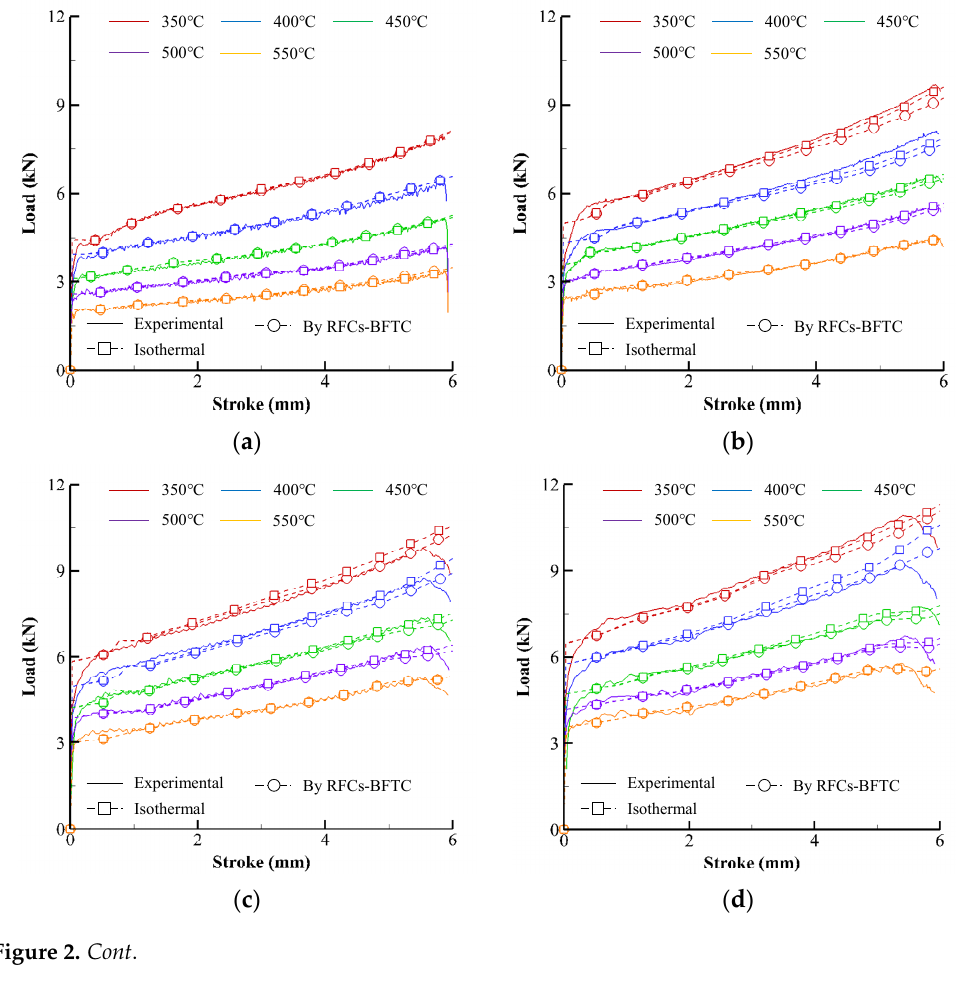
The compression test at 450 ◦ C and a strain rate of 10 s − 1 was selected for checking the validity of the calculated flow curves in the next section. Note that the measured maximum diameter of the compressed specimen was 13.7 mm at the final stroke of 6.3 mm. Solid lines in Figure 2 describe the experimental compression load–stroke curves (experimental CLSCs). The dashed lines with square or circle marks in Figure 2 repre- sent the CLSCs obtained by isothermal and non-isothermal flow analyses of the cylinder compression test, respectively, using the primitive flow curves directly calculated from Solid lines in Figure 3 exhibit the approximate primitive flow curves for the sample the experimental CLSCs (see the RFCs–BFTC in Figure 3). Note that the oscillation of the temperatures and strain rates, termed the reference flow curves before friction compensa- compression load of the specimen with the initial temperature (550 ◦ C) near the melting tion and temperature compensation (RFCs–BFTCs), which were calculated under the as- temperature can be observed in Figure 2 as the strain rate and strain increases. The maxi- sumption of isothermal and homogeneous cylinder compression, viz without any com- mum measured temperature at the barreled surface reached 557 ◦ C, implying that internal pensation for friction and temperature effects on flow behavior. local melting might occur during the compression test at the strain rate of 20 s − 1 .